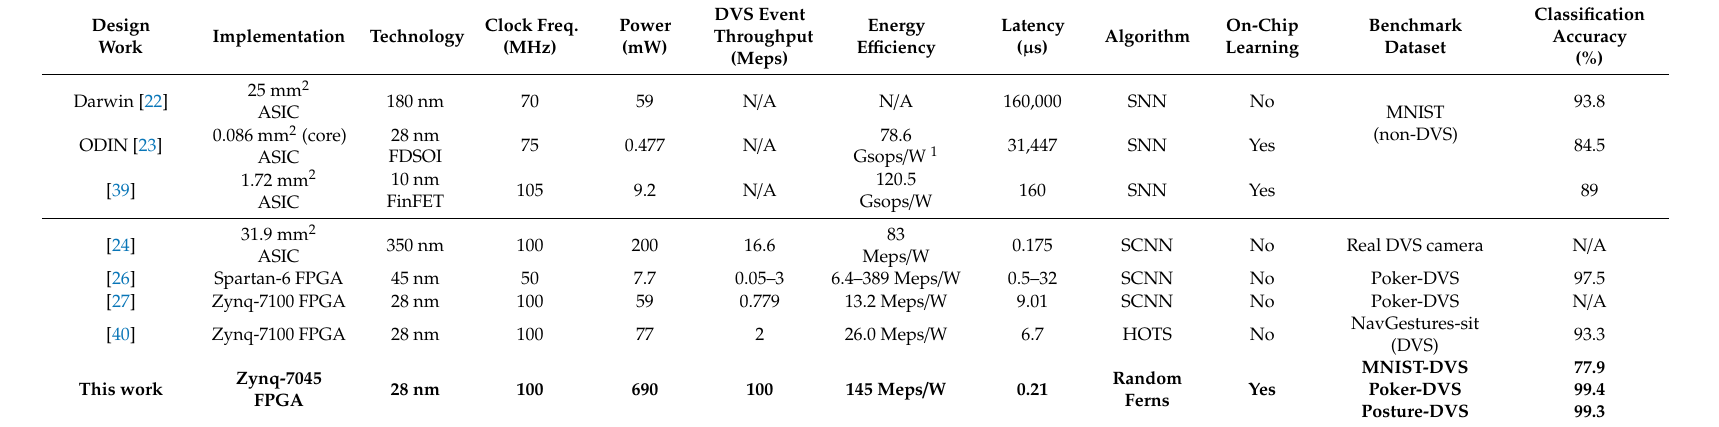
Table 4. Comparison to other digital VLSI implementations for AER visual